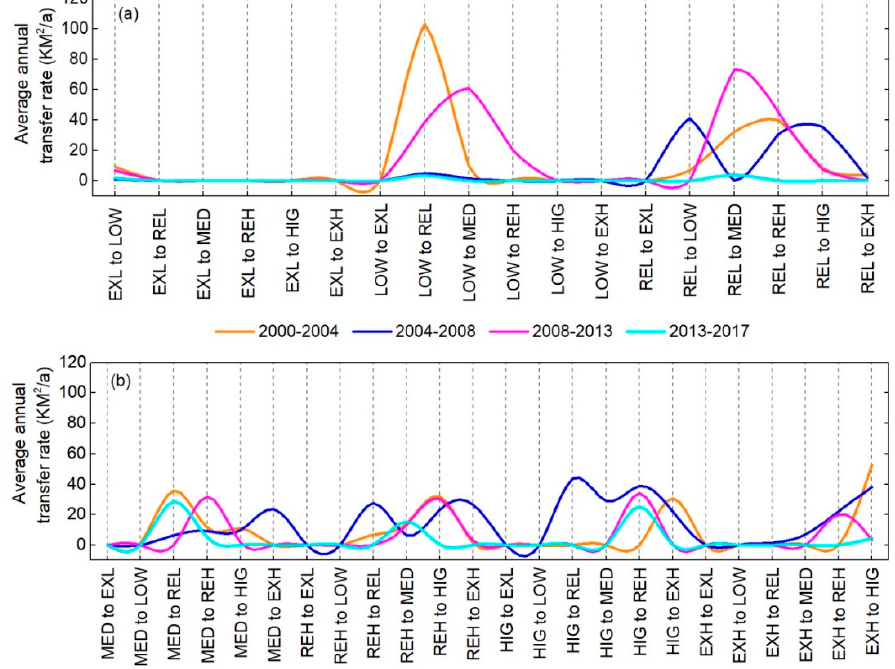
Figure 9. Annual transfer rates of different ecological risk grades during 2000–2014, 2004–2008, 2008–2013, and 2013–2017 (km 2 /year). ( a ) Map of annual transfer rates of different ecological risk grades transposed from EXL, LOW, and REL; ( b ) map of annual transfer rates of different ecological risk grades transposed from MED, REH, HIG, and EXH. Notes: EXL: extremely low; LOW: low; REL: relatively low; MED: medium, REH: relatively high; HIG: high; EXH: extremely